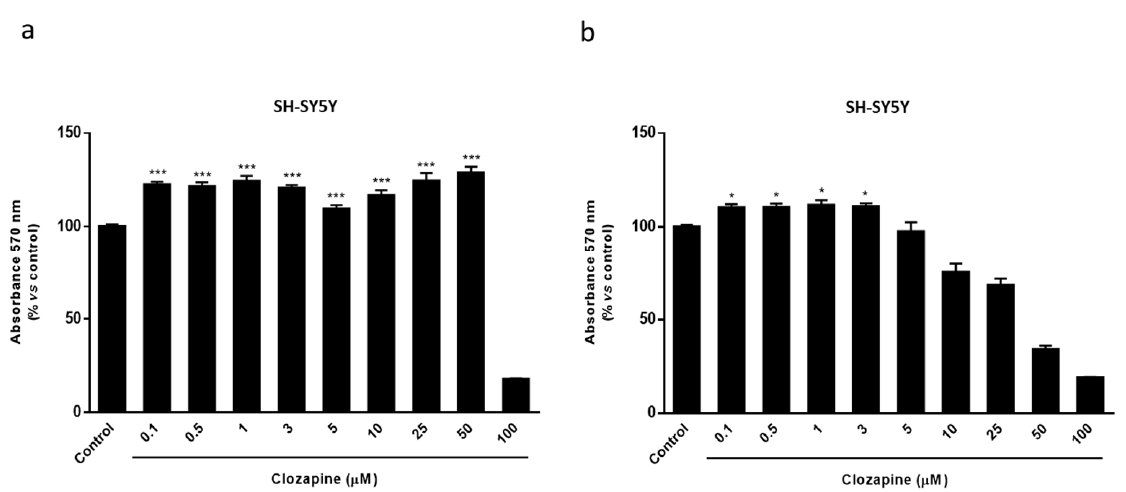
Figure A2. MTT assay in SH-SY5Y cells treated with increasing concentrations of CLO (0.1–100 µM) during 24 h ( a ) and 48 h ( b ). Cell damage is represented as the percentage of viability versus control. Data are the mean ± SEM of five independent experiments. Significant differences were analyzed by a one-way ANOVA followed by post-hoc Tukey’s test. * p < 0.05, *** p < 0.001 com- pared with control.